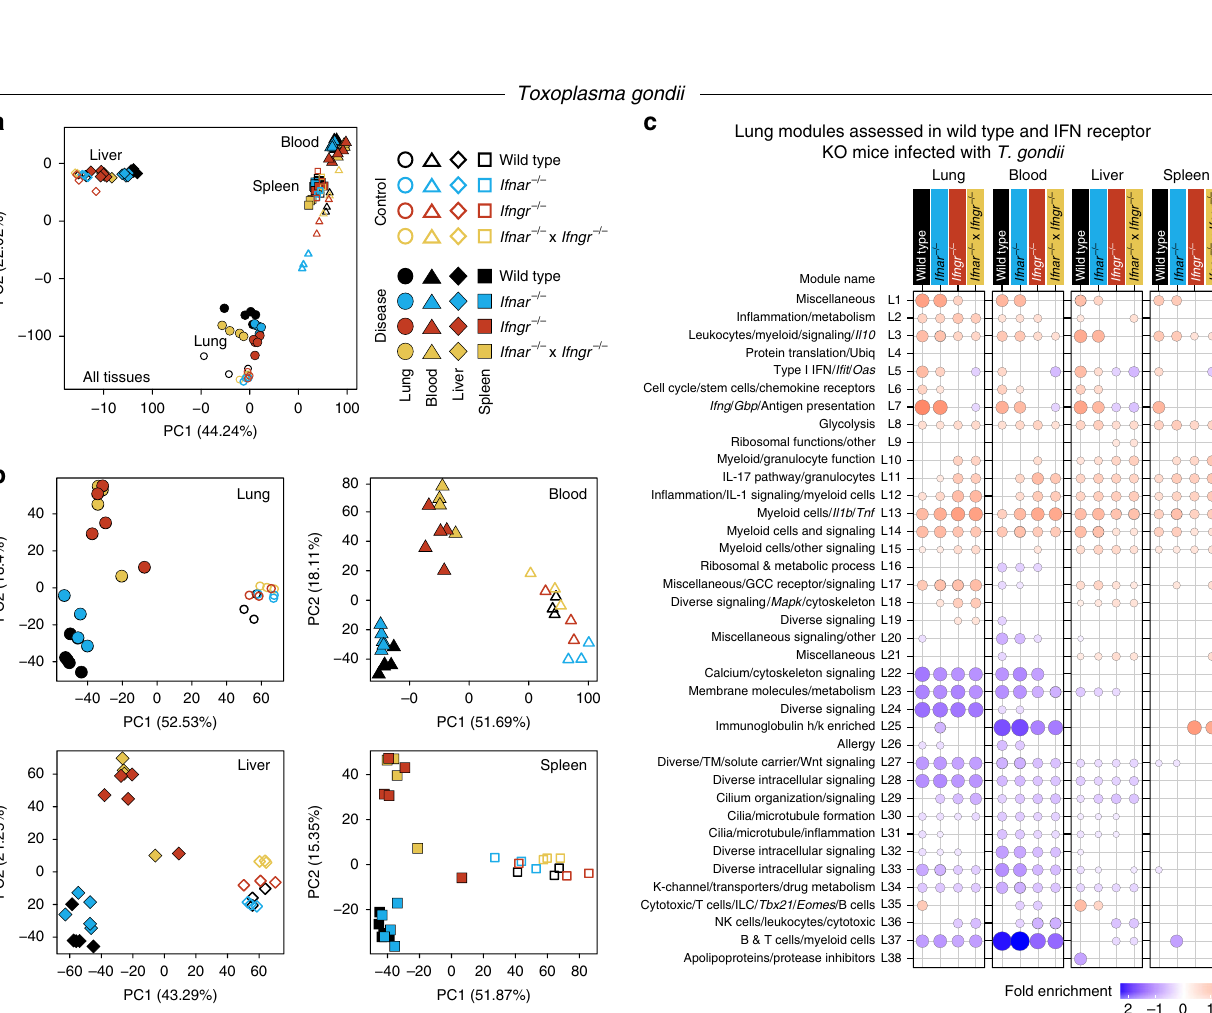
Fig. 4 Gene networks of IFN-associated lung modules in lung and blood across diseases. Gene networks for L5 (Type I IFN/ I fi t / Oas ) and L7 ( Ifng / Gbp / Antigen presentation) modules depicting the “ hub ” genes representing genes with high intramodular connectivity, i.e., genes most connected with all other genes within the module. For each module, a representative network is shown for Toxoplasma with gene names, followed by smaller gene networks for the 6 diseases. Each gene is represented as a circular node with edges representing correlation between the gene expression pro fi les of the two respective genes. Color of the node represents log 2 foldchange of the gene for each disease compared to its respective controls, in the lung (left panel) and blood (right panel) samples for both modules. Pearson correlation coef fi cients ( r ) for foldchanges for all genes (disease samples compared to respective controls) in the L5 and L7 modules between lung and blood are shown